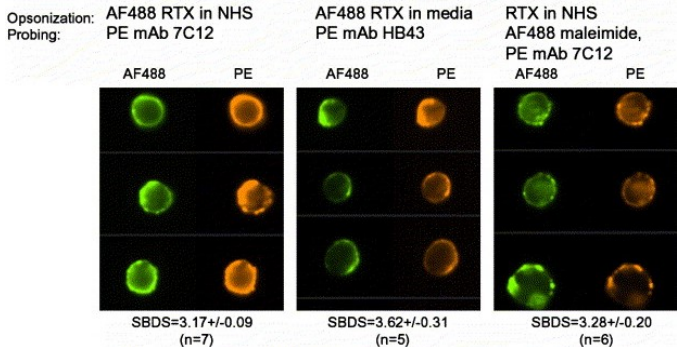
Figure 3. Deposited C3b colocalizes with bound RTX. Representative images from samples opsonized as indicated and then analyzed by HRDI. Similarity bright detail score (SBDS) values given below the images are the mean ± SD ( n ) for values obtained on ‘ n ’ different replicate samples (at least 10,000 cells/sample) prepared and analyzed over a period of 18 months. The AF488 maleimide binds to the free SH group on C3b. Note how it is colocalized with mAb 7C12, specific for C3b. Reprinted from Journal of Immunological Methods, Vol. 317, 2006, Beum, P.V. et al., Quantitative analysis of protein colocalization on B cells opsonized with rituximab and complement using the ImageStream multispectral imaging flow cytometer, pp. 90–99, with permission from Elsevier, Amsterdam, The Netherlands [18] .